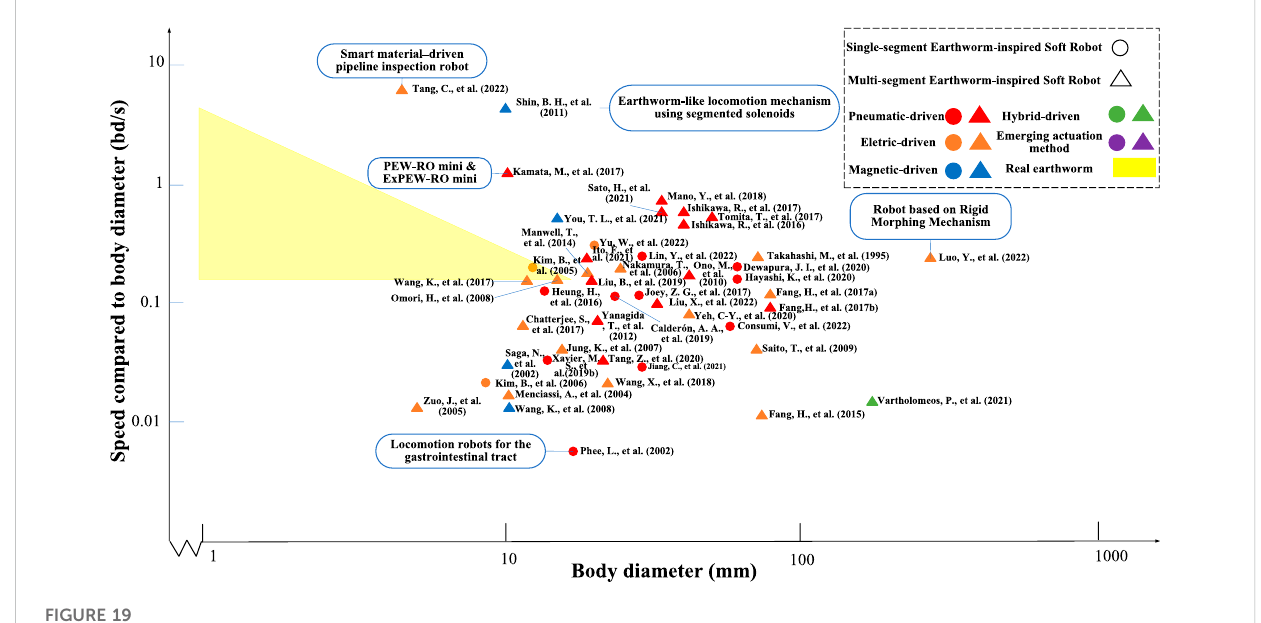
FIGURE 19 Comparison of standardized speed divided by body diameter of earthworm-inspired soft